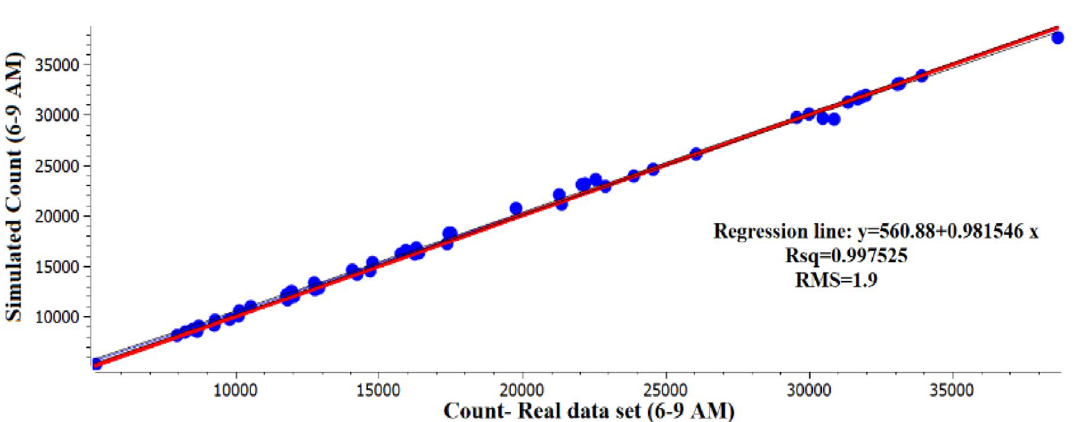
Figure 3. The Discrete GEH Statistic view mode for count.